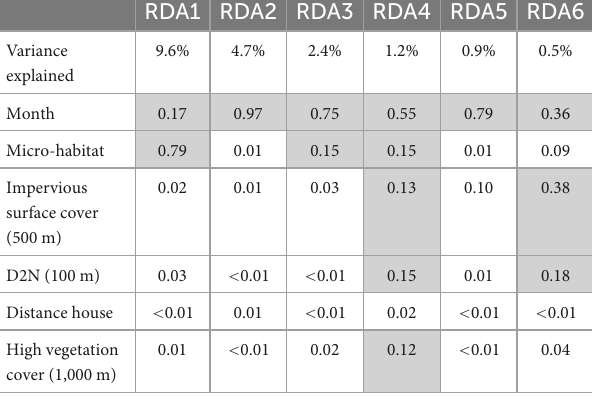
correlated with “micro-habitat” while RDA2, RDA3, and RDA5 are primarily associated with “month.” RDA4 and RDA6 are associated with “month” and the four indexes of urbanisation level ( Table 2 ).